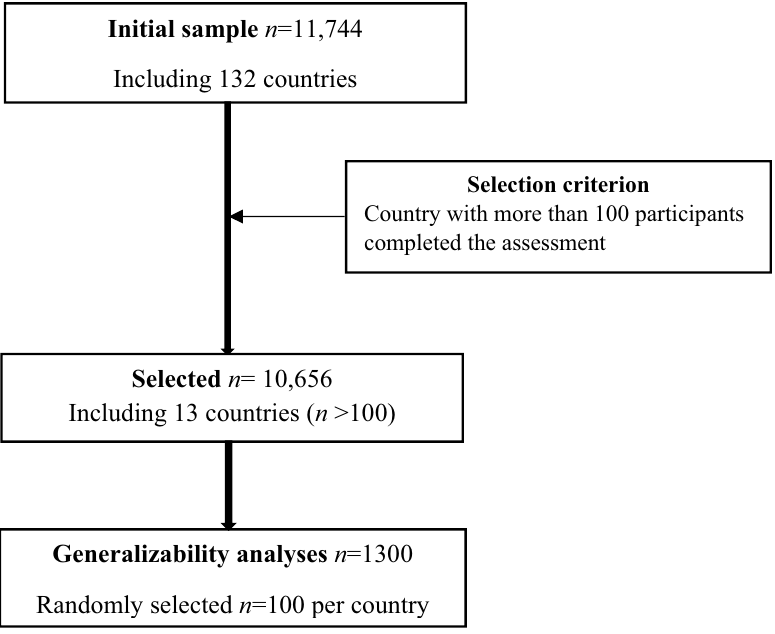
Figure 4. Consort flow diagram of the study sample selection for Generalizability analyses of the Stroke